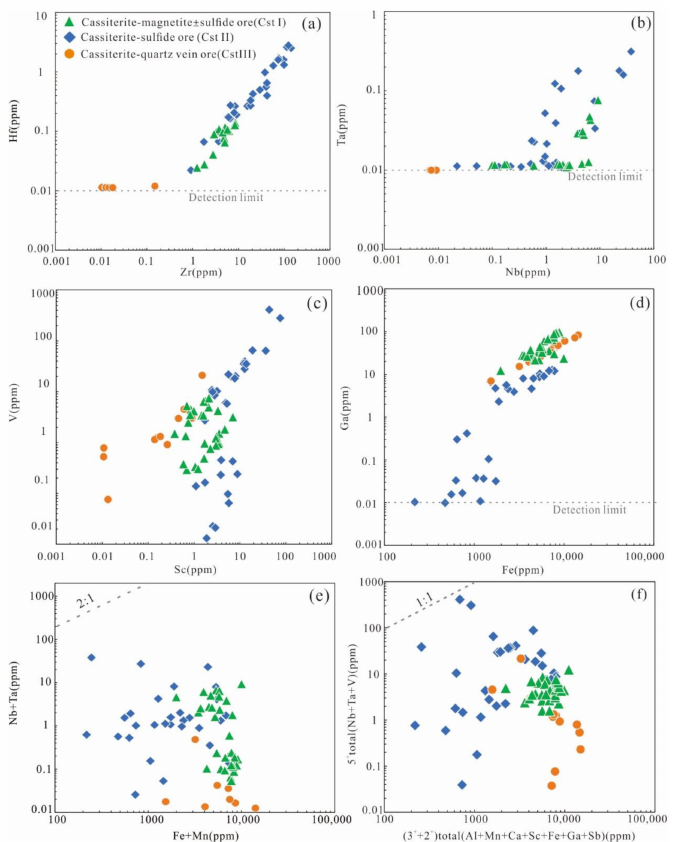
Figure 6. Binary plots of ( a ) Zr vs. Hf, ( b ) Nb vs. Ta, ( c ) Sc vs. V, ( d ) Fe vs. Ga, ( e ) Fe + Mn vs. Nb + Ta, ( f ) Al + Mn + Ca + Sc + Ga + Sb vs. Nb + Ta + V in cassiterite samples from the Dulong